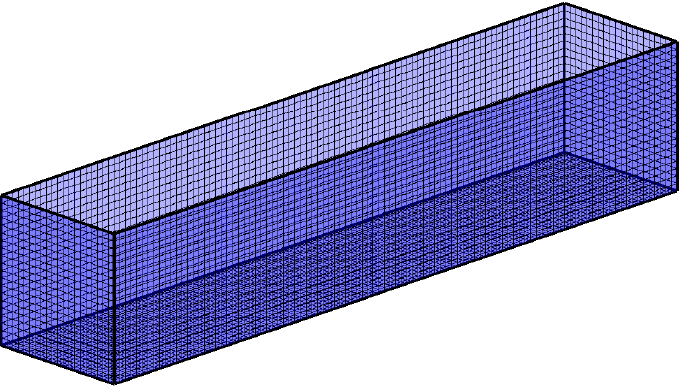
Figure 12. Finite element model.